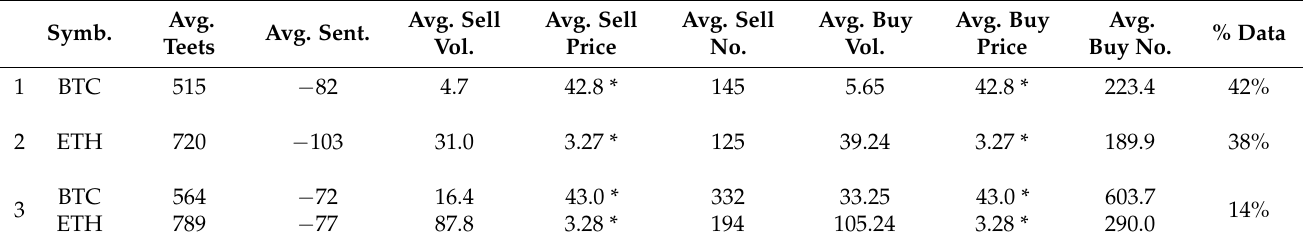
Table 4. Average values separated by